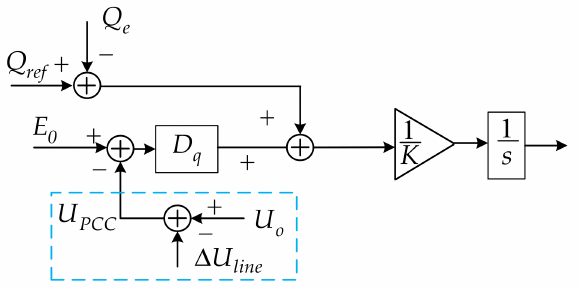
Figure 3. Block diagram of the improved reactive voltage control of the